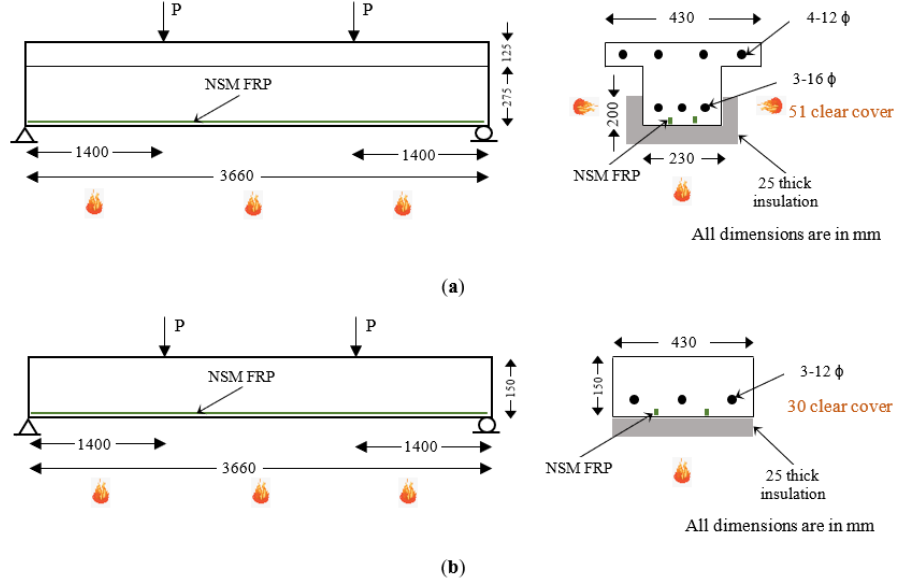
Figure 3. Layout and geometric details of RC members strengthened with NSM-type FRP reinforce- ment. ( a ) RC T-beam strengthened with NSM FRP reinforcement; ( b ) RC slab strengthened with NSM FRP reinforcement.